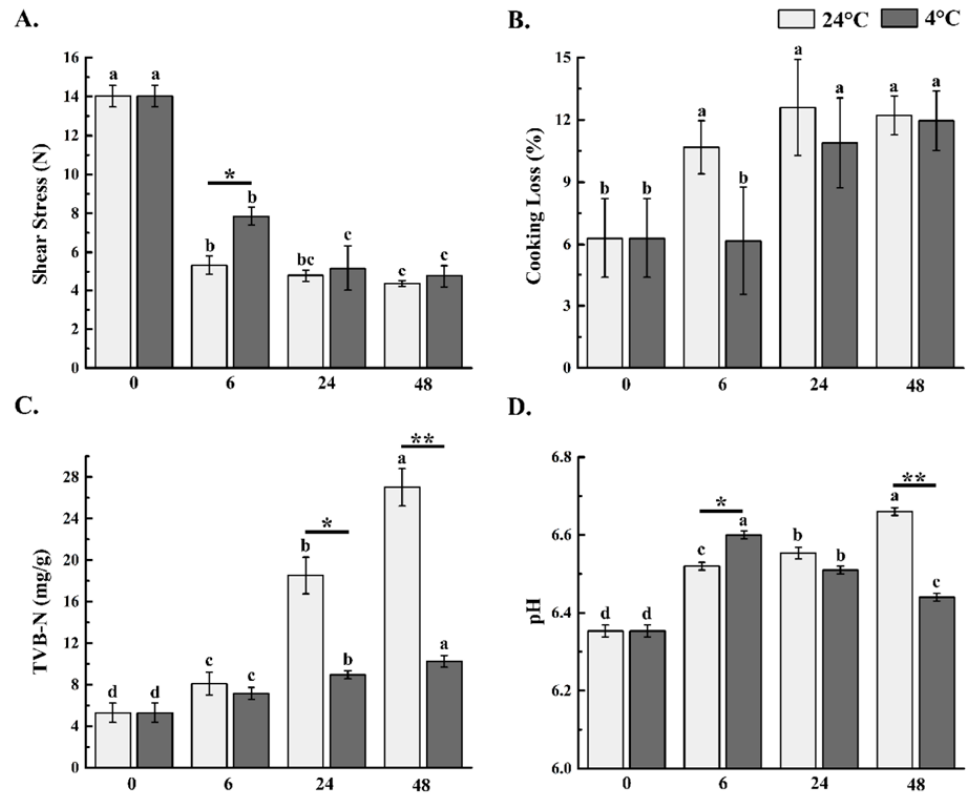
Figure 1. Changes in shear stress ( A ), cooking loss ( B ), TVB-N ( C ), and pH ( D ) of American shad during storage. Values are given as mean ± SD from triplicates determination. Different lowercase letters indicate significant differences at different storage times ( p < 0.05). Asterisks indicate significant differences at different storage temperatures (* p < 0.05; ** p < 0.01).